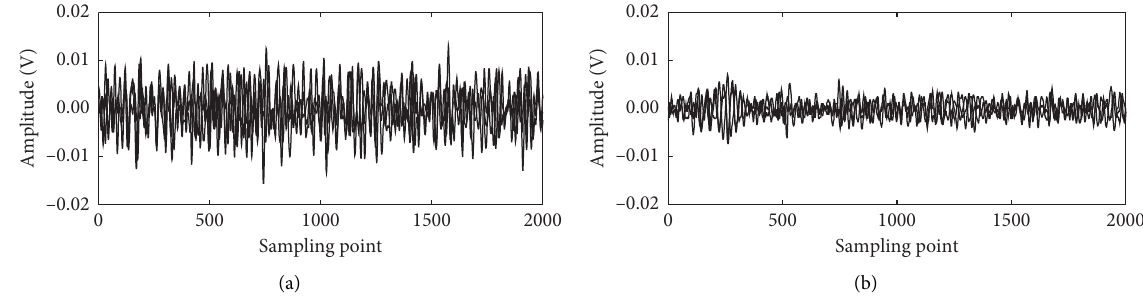
Figure 5: Pipeline leakage original signal: (a) upstream no. 1 sensor pipeline leakage original signal and (b) downstream no. 2 sensor pipeline leakage original signal.